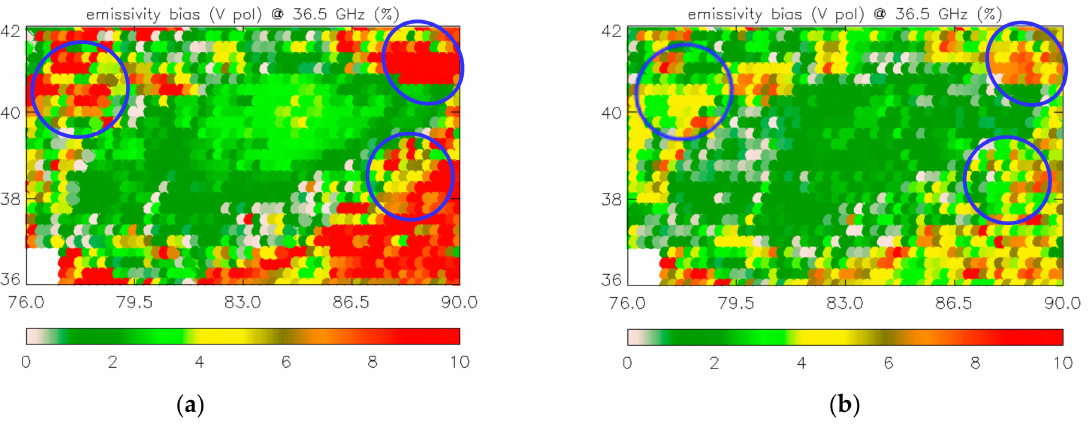
Figure 6. Comparison of emissivity bias between the retrievals and simulations (37.5 GHz, V-pol): ( a ) emissivity bias between the emissivity retrievals and original simulations; ( b ) emissivity bias between the emissivity retrievals and new